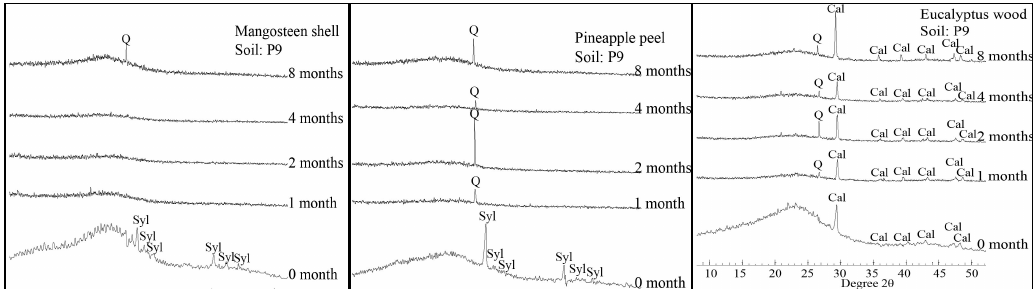
Figure 1. X-ray diffraction patterns of mangosteen shell, pineapple peel, and eucalyptus wood biochars for original biochar and biochar recovered from soil (P9) after 1, 2, 4, and 8 months. The vertical axis (intensity) scale differs between patterns.